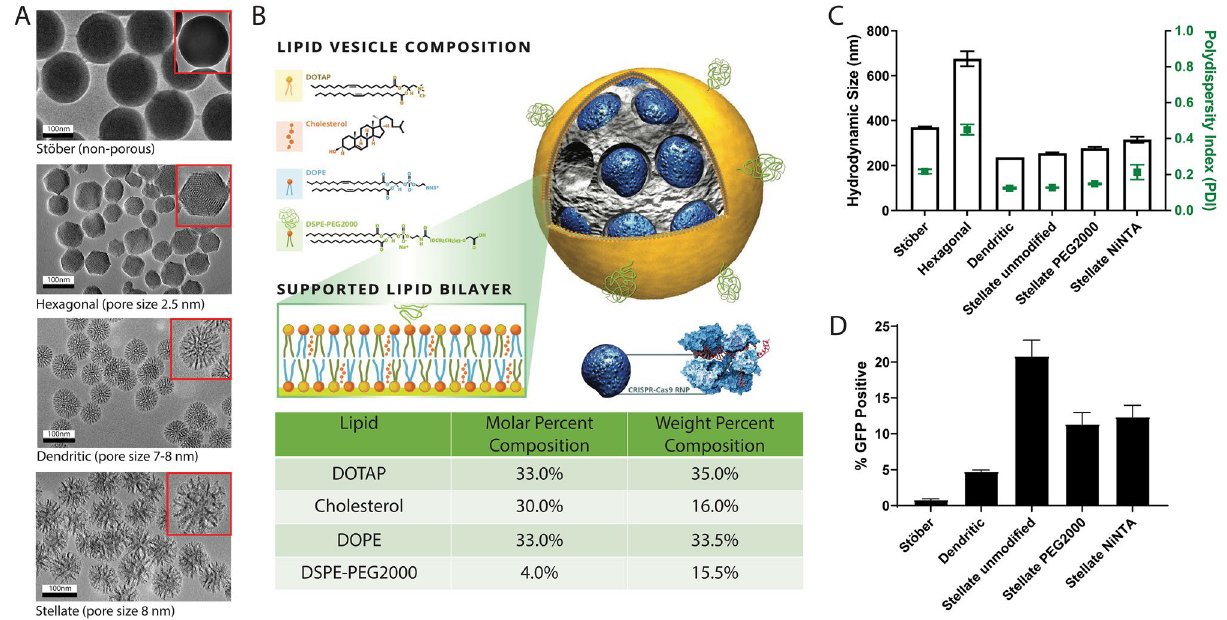
Figure 1. MSN screening identifies an optimal LCMSN formulation for cellular delivery of CRISPR RNP. ( A ) TEM images of 4 non-lipid coated MSN particle types: St ӧ ber, hexagonal, dendritic, and stellate morphologies. ( B ) Schematic of the LCMSN platform highlighting the composition of lipid coating in the DCD3330 formulation. ( C ) Hydrodynamic size (black) and polydispersity index (green) measurements of RNP loaded LCMSNs determined by DLS. ( D ) Screening of RNP-LCMSN formulations using a reporter cell line (Fig.